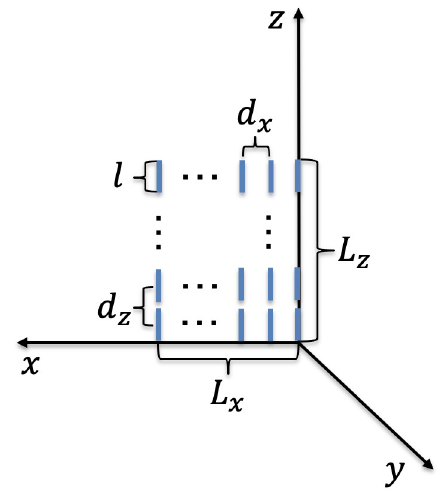
Figure 6. Dipole topology on the xoz plane with element spacing of d x and d z , and array lengths of L x and L z on the x - and z -axes, respectively. Each dipole element is of length l = λ